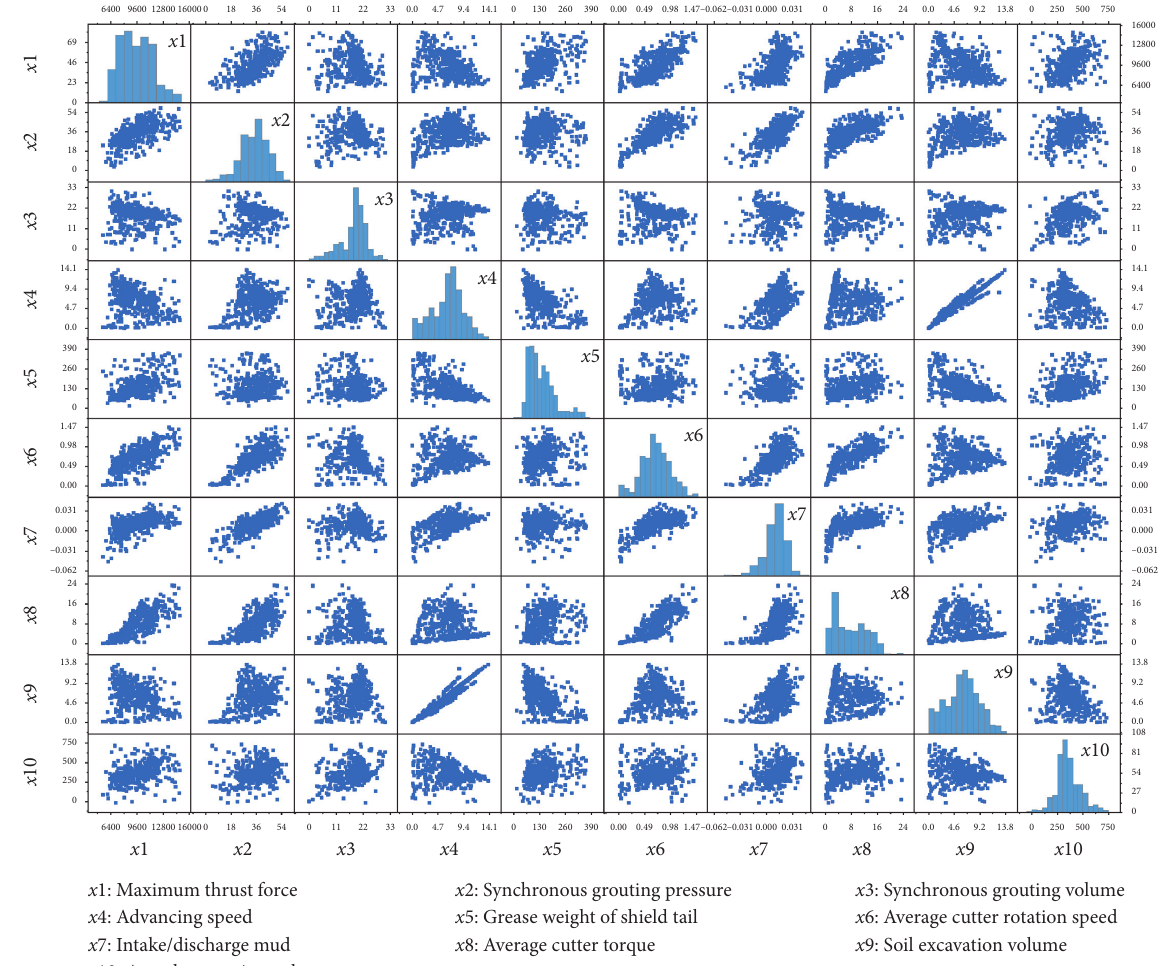
Figure 3: The scatter matrix for each input